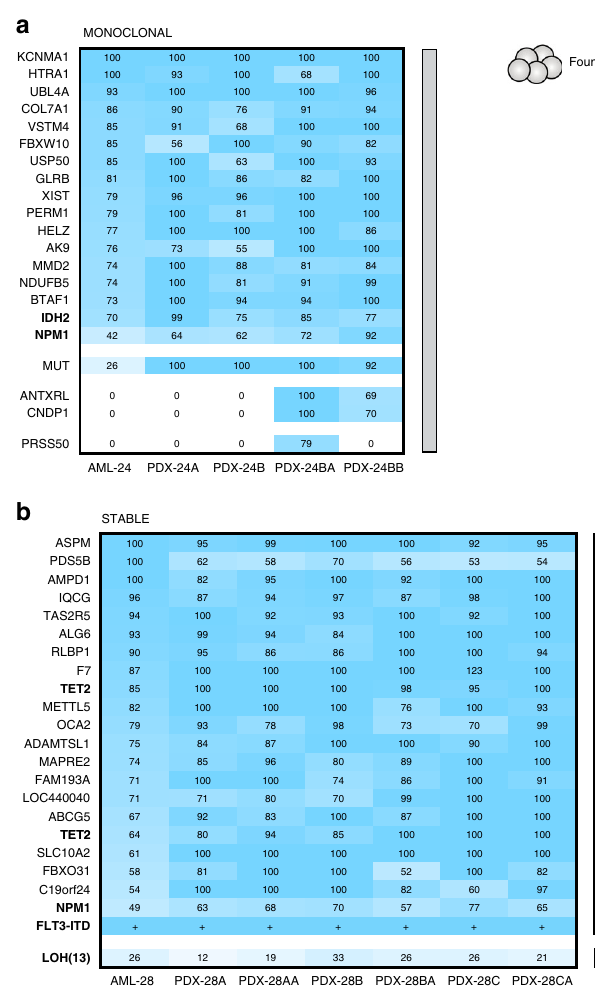
Fig. 2 The clonal composition is maintained in a minority of AML xenografts. a A representative AML case with the Monoclonal pattern of clonal dynamics, where the patient sample only contains one detectable clone with AML-associated mutations or CNAs and this clone constitutes the entire xenografts. In AML-24, a single clone with IDH2 and NPM1 mutations gave rise to both the two primary and the two secondary xenografts, differing only in terms of nonrecurrent presumed passenger mutations. Left, the percentage of cells in patient samples and corresponding xenografts estimated to carry each genetic aberration, based on variant allele frequencies of identi fi ed mutations and b-allele frequencies of copy number alterations and copy-neutral losses of heterozygosity. Colored bars indicate de fi ning mutations for each clone. Clones are represented by the same color throughout each panel. Middle, inferred clonal hierarchy. Right, proportions of each clone at diagnosis (AML, thick circles) and in xenografts (PDX, thin circles). Clones were de fi ned by the presence of one or more recurrent AML mutations, CNAs or losses of heterozygosity (indicated in bold). b The only AML case with the Stable pattern of clonal dynamics, where clones in the patient sample retain their relative proportions in the xenografts. In AML-28, a subclone with loss of heterozygosity of chromosome 13 maintained its frequency from the patient sample in all three primary and three secondary xenografts. The presence of FLT3 -ITD is denoted by + , as the rearrangement in this case is detectable but not quanti fi able by